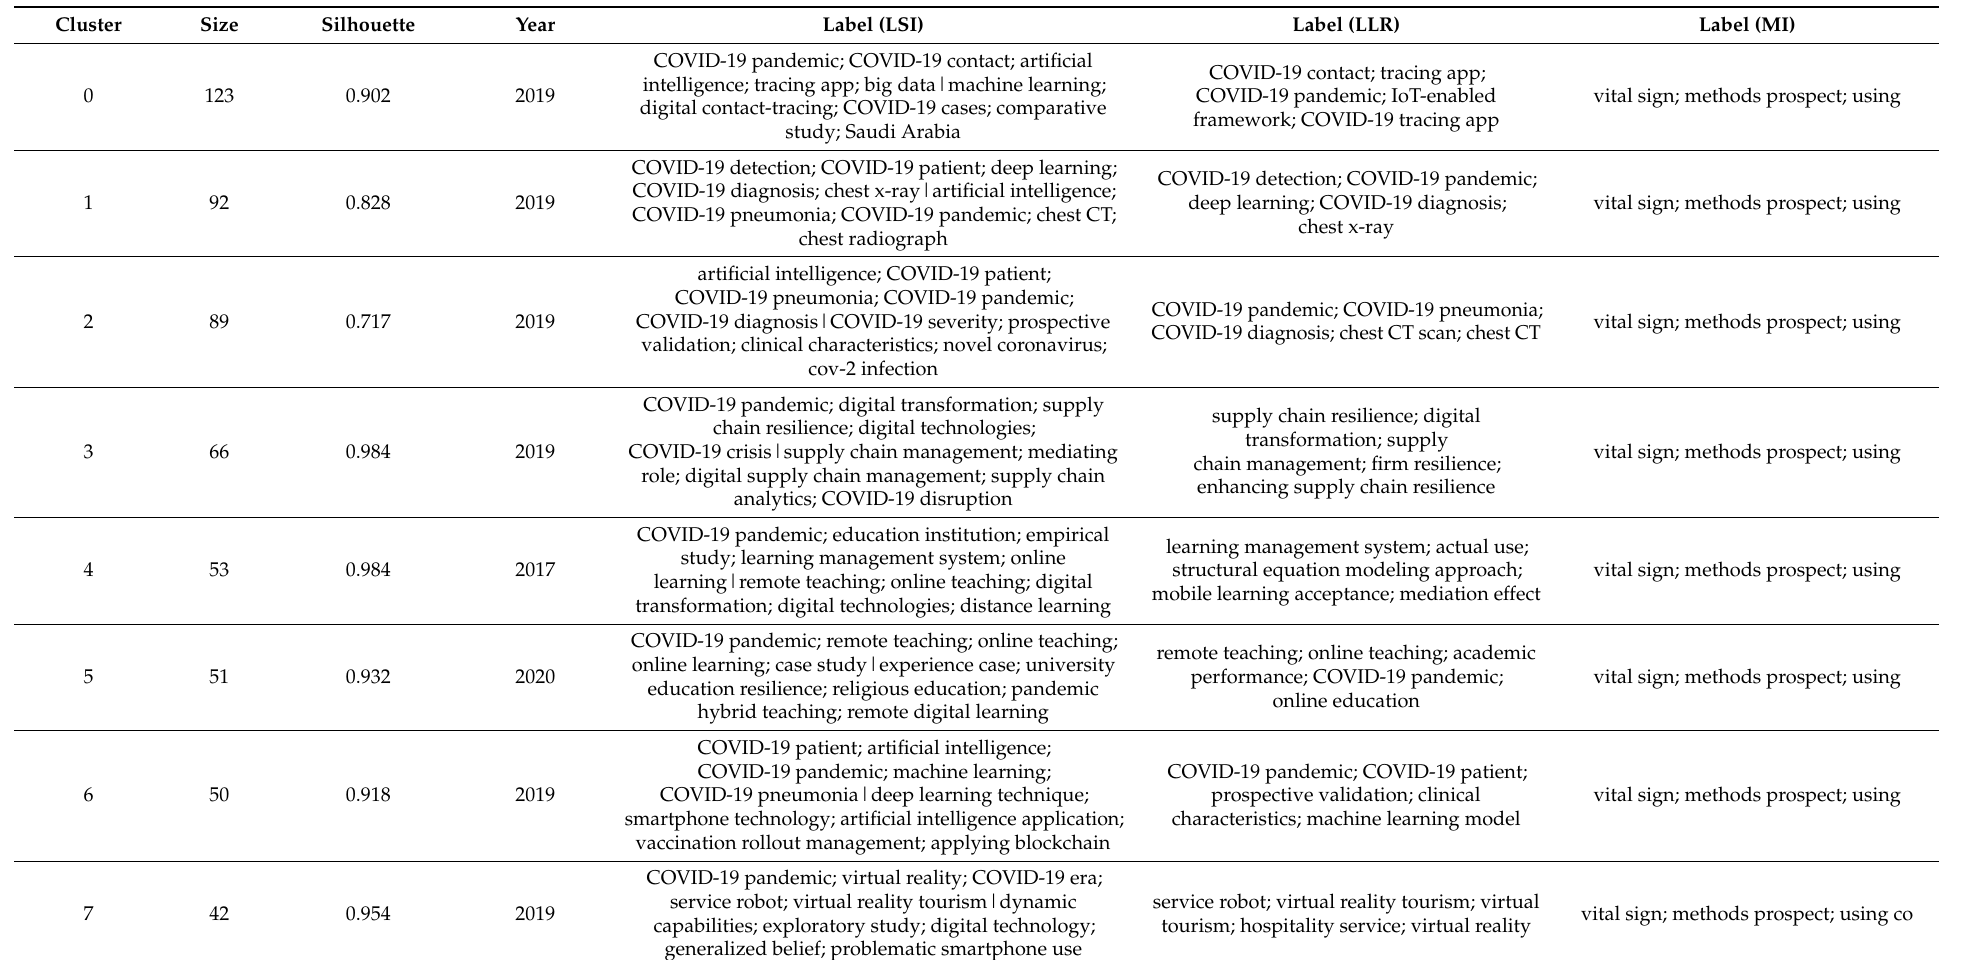
Table 6. Label list of clustering categories in literature co-citation